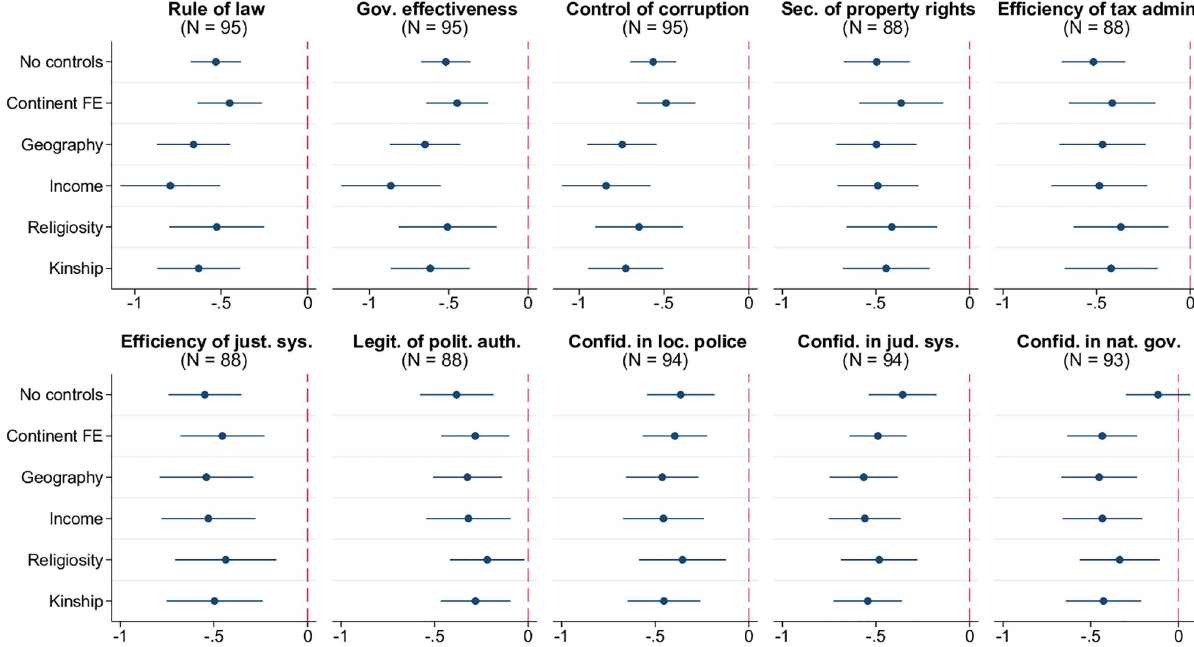
Fig 3. Witchcraft beliefs and institutions. Each panel of the figure presents the results of estimating 6 different models, in which the prevalence of witchcraft beliefs at the country level is regressed on the metric of institutions indicated in the panel title, along with a set of control variables. The latter is defined as follows according to the tickmarks on the vertical axis: 1) none for “No controls”, 2) only continental fixed effects for “Continent FE”, 3) continental fixed effects and baseline geographic controls (absolute latitude, terrain ruggedness, agricultural suitability of land, distance to the coastline) for “Geography.” The remaining 3 models, named “Income,” “Religiosity,” and “Kinship,” include, respectively, real GDP per capita, average religiosity, and kinship intensity index (in addition to continental fixed effects and geographic variables). The round marker represents the point estimate for the coefficient on the respective index of institutions, and the linear segment around each marker is the corresponding 95% confidence interval based on heteroskedasticity-robust standard errors. Confidence intervals that do not cross the reference vertical line at 0 correspond to statistical significance of the respective point estimates at the 5% level. Sample size N indicated in parentheses. The key variables are standardized to have zero mean and unit standard deviation in relevant